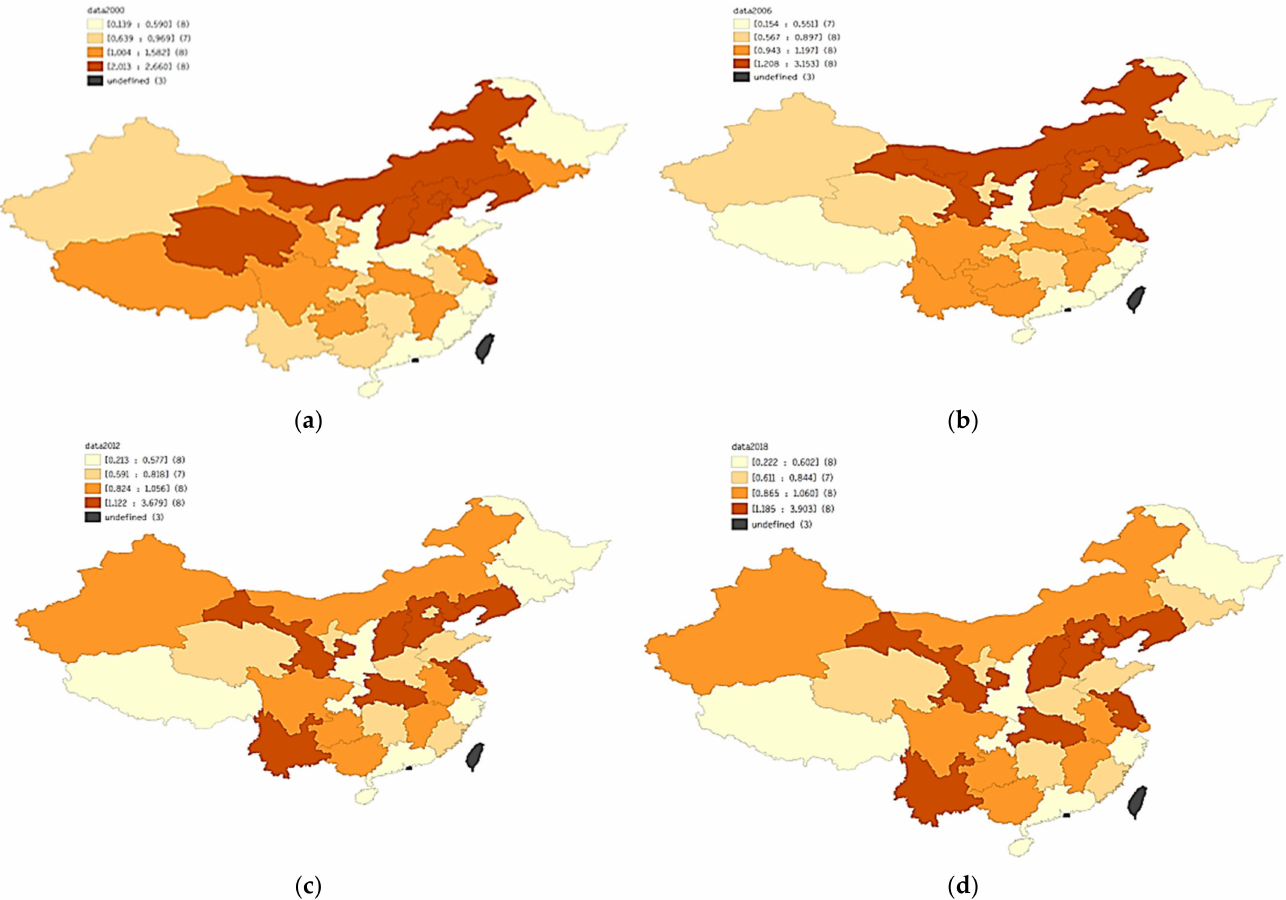
Figure 1. Entropy statistics of the concentration of iron and steel industry locations in various provinces of China. ( a ) 2000, ( b ) 2006, ( c ) 2012, ( d )